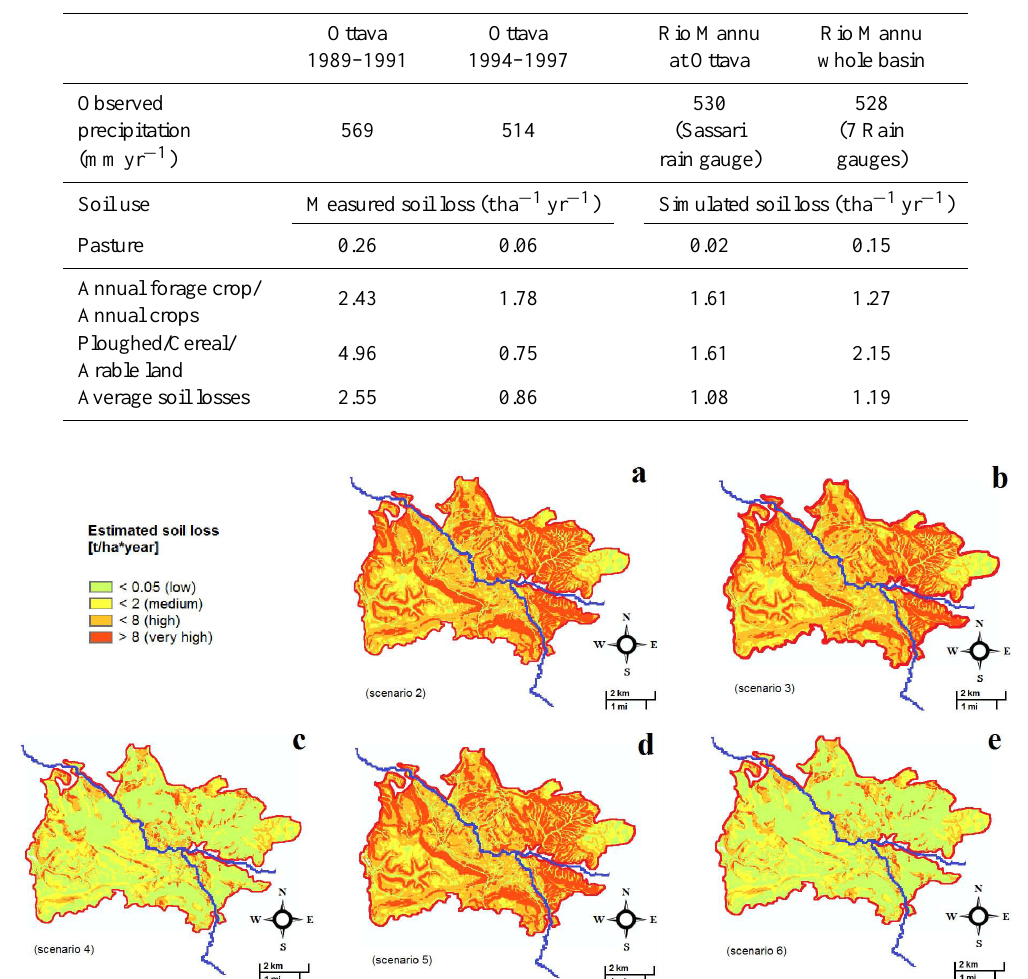
Table 6. Simulated soil losses vs. measured soil losses for the area of Ottava and for the Rio Mannu Basin.